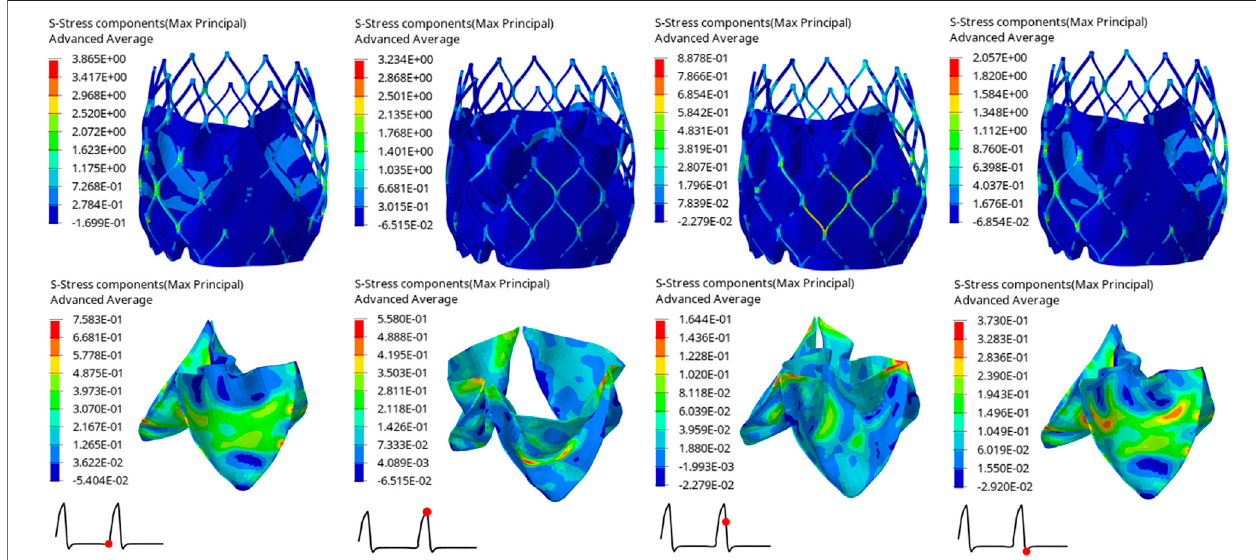
FIGURE 11 | Maximum principal stress distribution of valve stent and valve lea fl et of model C.